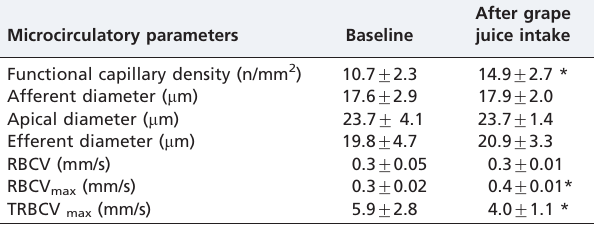
Table 2 - Microcirculatory parameters of triathletes before (baseline) and 20 days after OGJ intake (n=